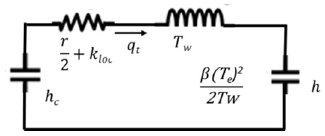
Figure 3. Scheme of the short penstock model.